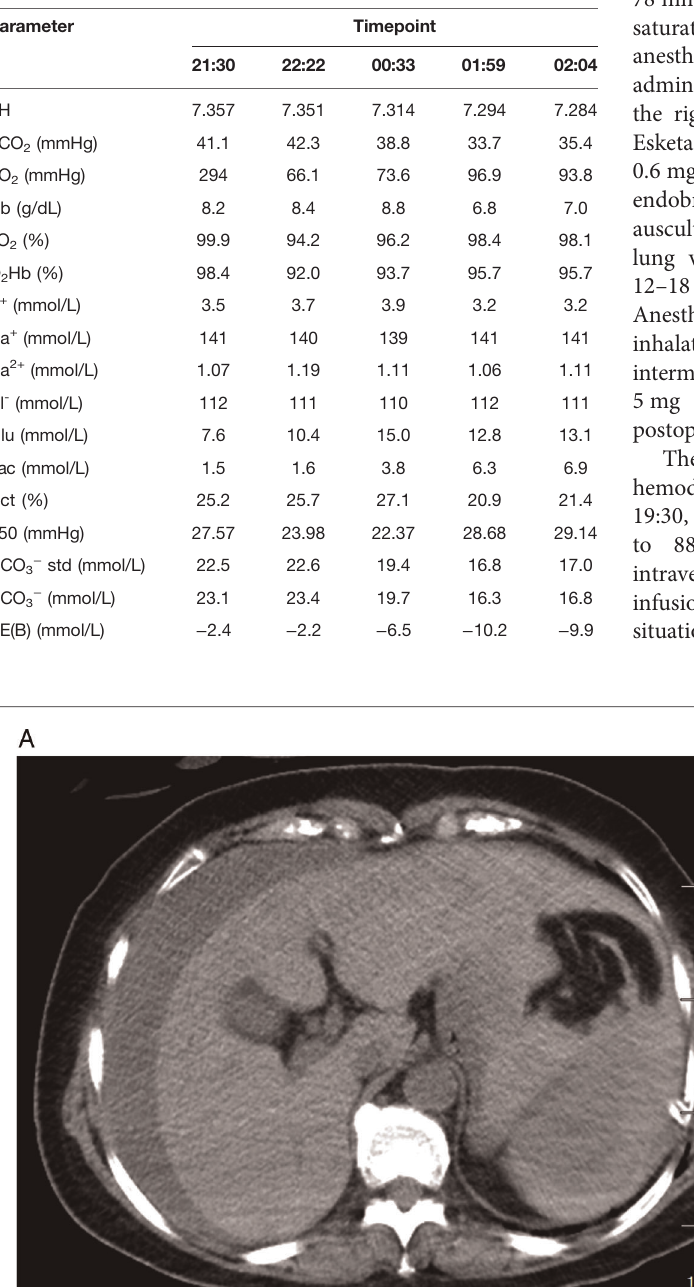
TABLE 1 | Arterial blood gas and electrolyte analyses.